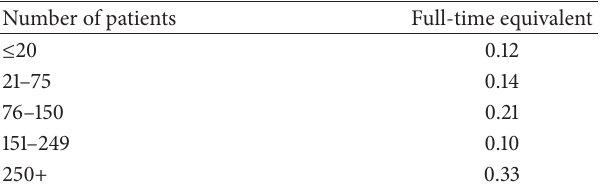
Table 9: Psychiatrist or